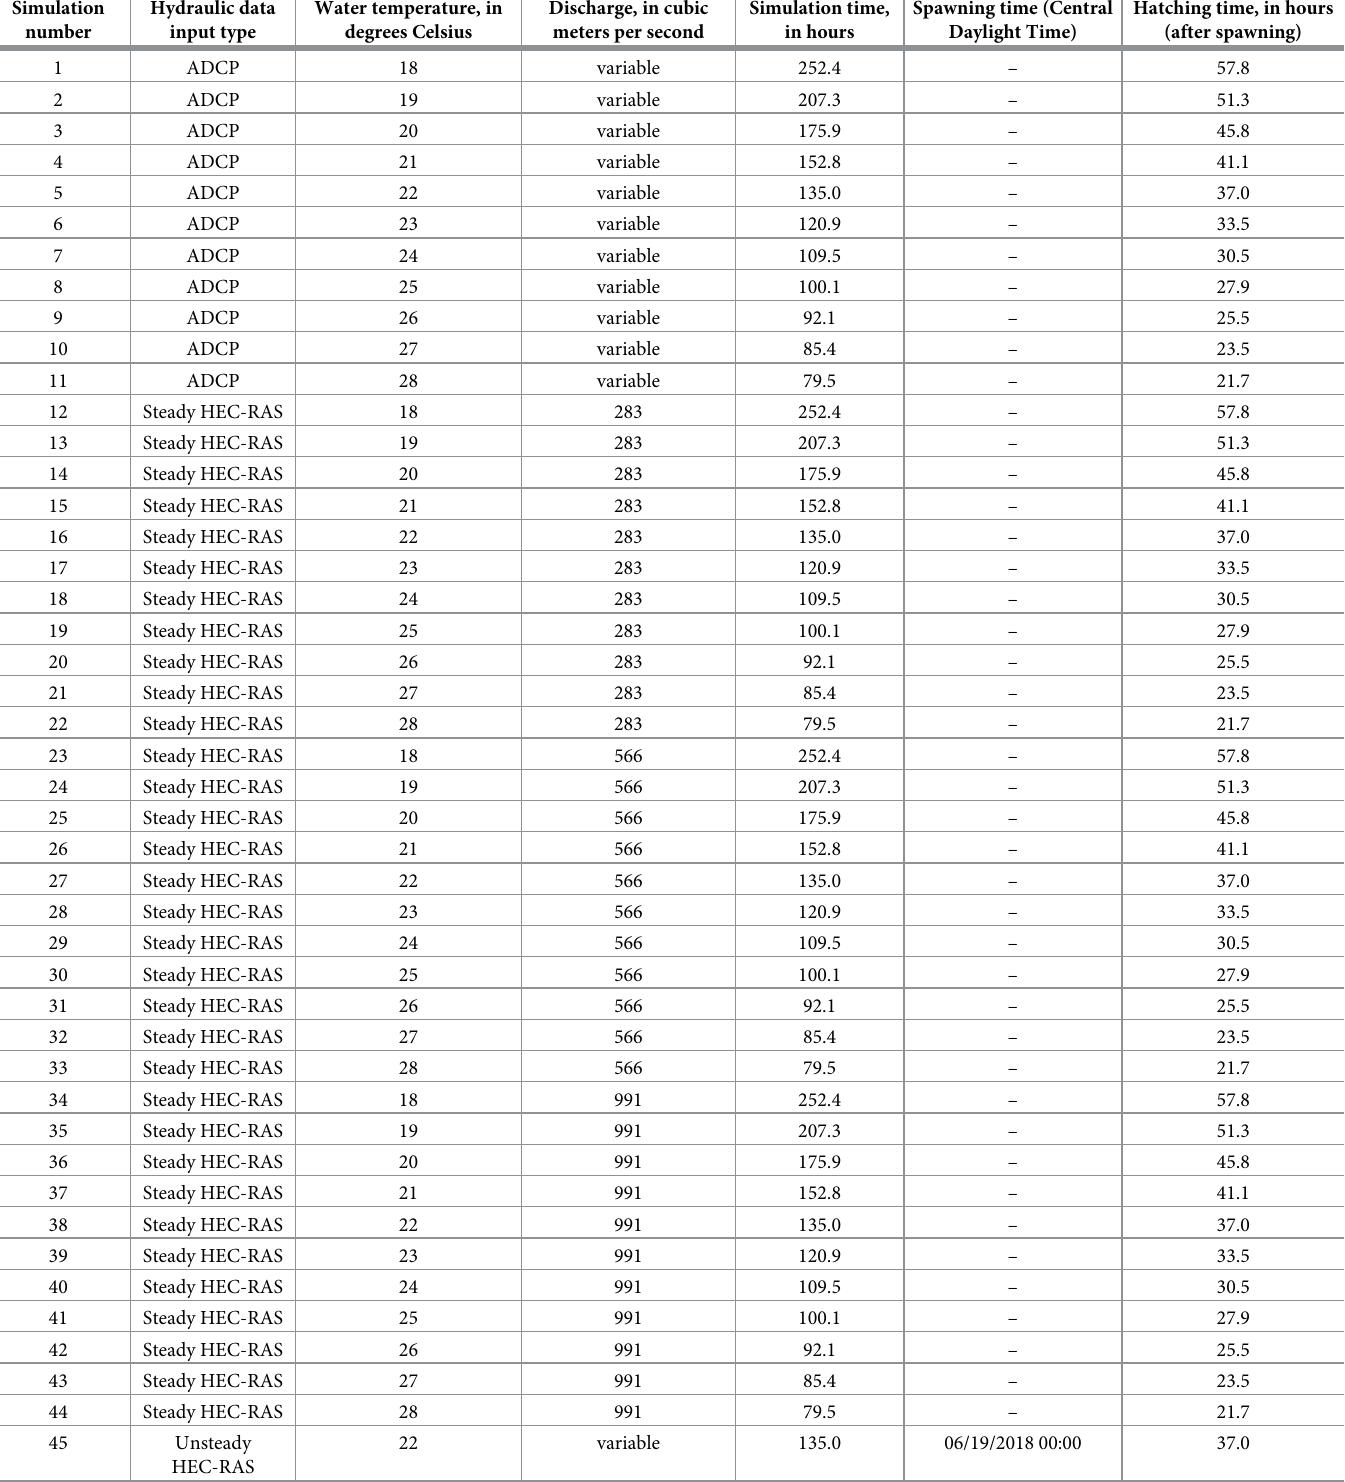
Table 1. FluEgg simulations performed for hypothetical bighead carp spawning in the St. Croix River (Minnesota, Wisconsin). Spawning is assumed to occur in the tailwater of the St. Croix Falls hydropower plant in the center of the channel and at the water surface for all simulations. All simulations released 10,000 bighead carp eggs at the spawning location and were run until larvae reached the gas bladder inflation stage (simulation time; computed from [18]). Hatching times are derived from